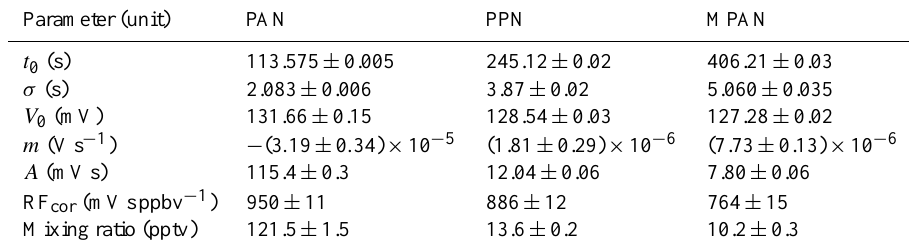
Table 11. Parameters of Eq. (1) fitted to the chromatogram in Fig. 12.